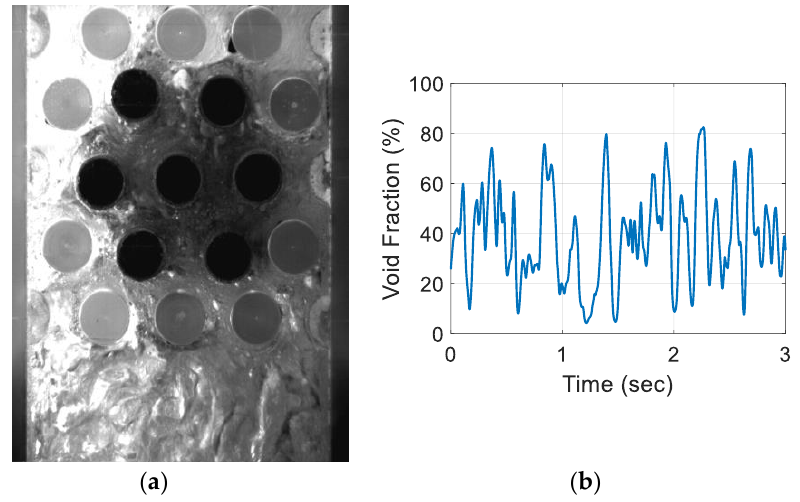
Figure 21. Experimental results for the one sensor configuration for an air flow rate at 40 L/min: ( a ) flow visualization and ( b ) void fraction signal.